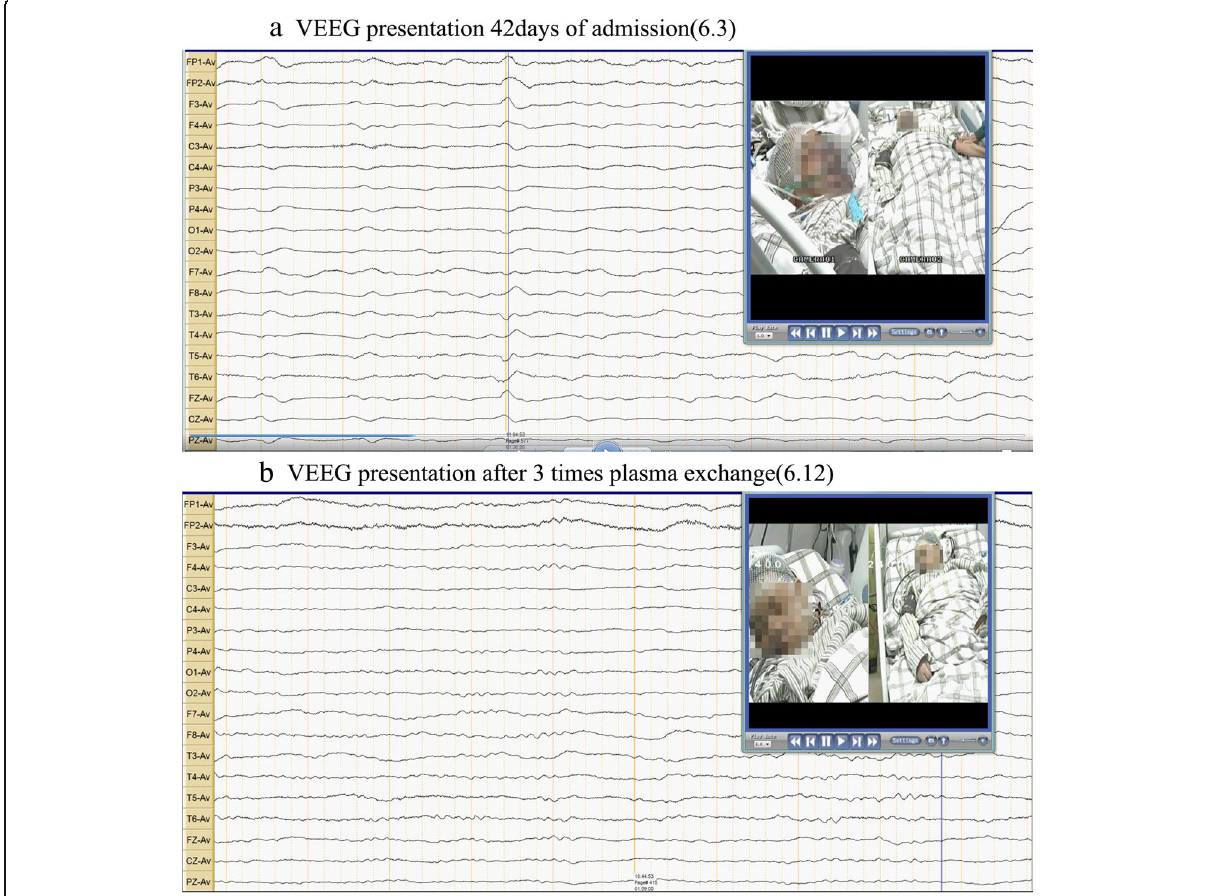
Fig. 4 Continuous VEEG presentation before and after plasma exchange. a Video electroencephalography (VEEG) presentation before plasma exchange 6 weeks after admission. The patient showed recurrent sweating profusely on the right forehead and enlargement of the right pupil. Continuous VEEG showed paroxysmal slow waves, especially 0.5 – 1 Hz/s slow waves, alternating with low voltage with no reactivity. b VEEG presentation after plasma exchange. After 3 times of plasma exchange, VEEG showed alpha rhythm and the patient recovered